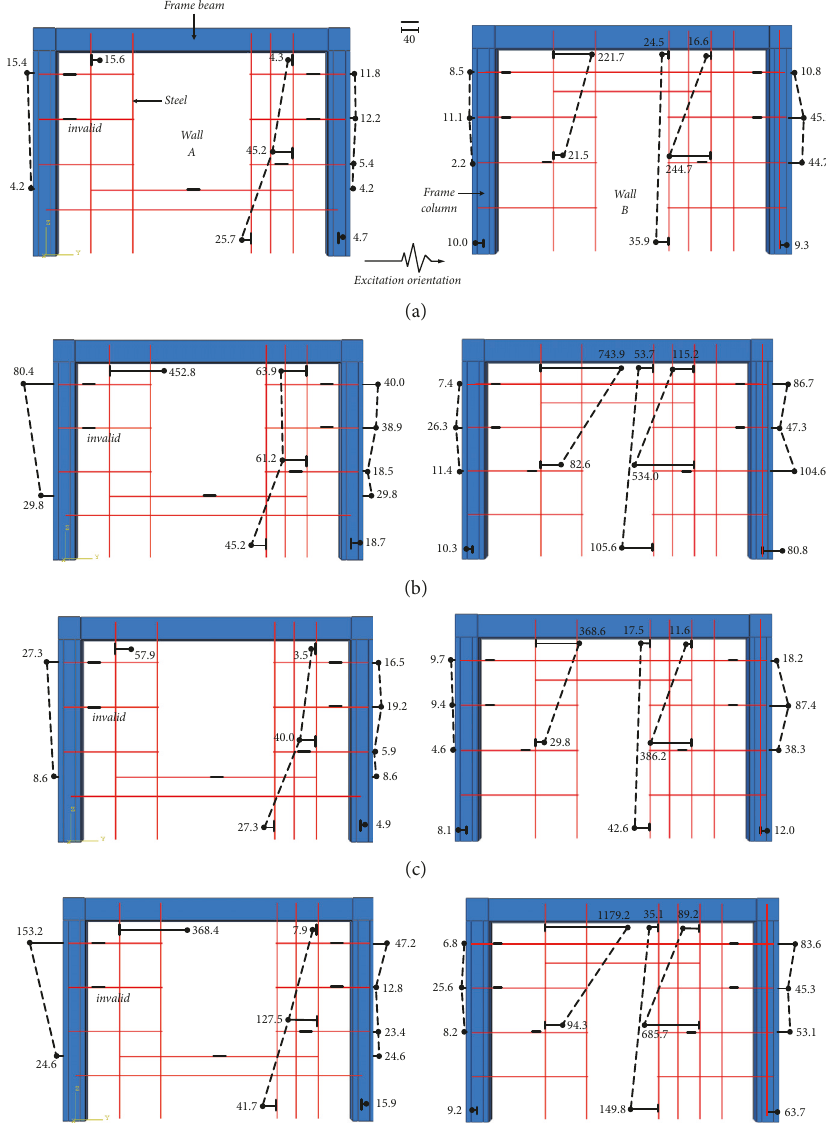
Figure 18: Distribution of the peak tensile strain under different input motions (unit: 𝜇𝜀 ): (a) Taft 0.1g, (b) Taft 0.3 g, (c) El Centro 0.1g, and (d) El Centro 0.3